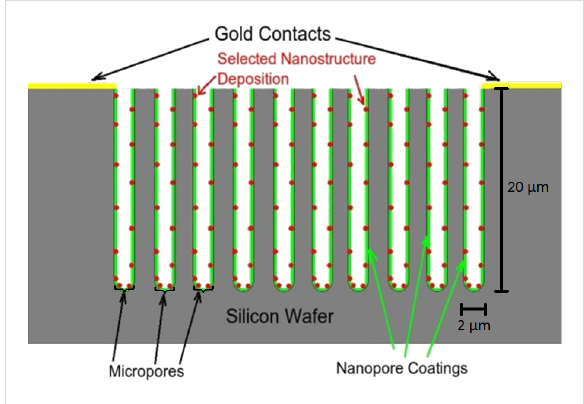
Figure 1: Schematic representation of PS sensor interface structure. Reproduced with permission from [3]. Copyright 2010 Wiley-VCH.